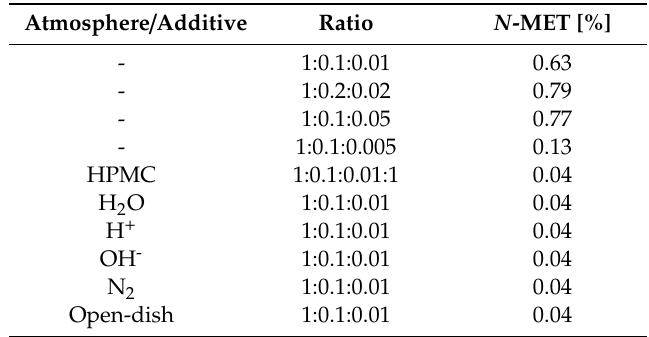
Table 5. Evaluation of di ff erent factors on the formation of % N -methyl paroxetine. Paroxetine hydrochloride alone or mixed with components from the formulation was weighed into glass vials in the ratios defined in the table (the first value indicates the drug substance, the second indicates PEG 6000, the third indicates Fe 2 O 3 , and the fourth indicates the additive). Mixtures of excipient components were separate from the drug substance. Additives were added to the excipient